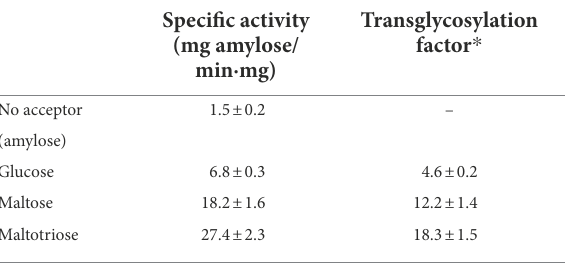
TABLE 1 Amylose degradation activity and transglycosylation factors of rPSGT in the presence of acceptors. Specific activity (mg amylose/